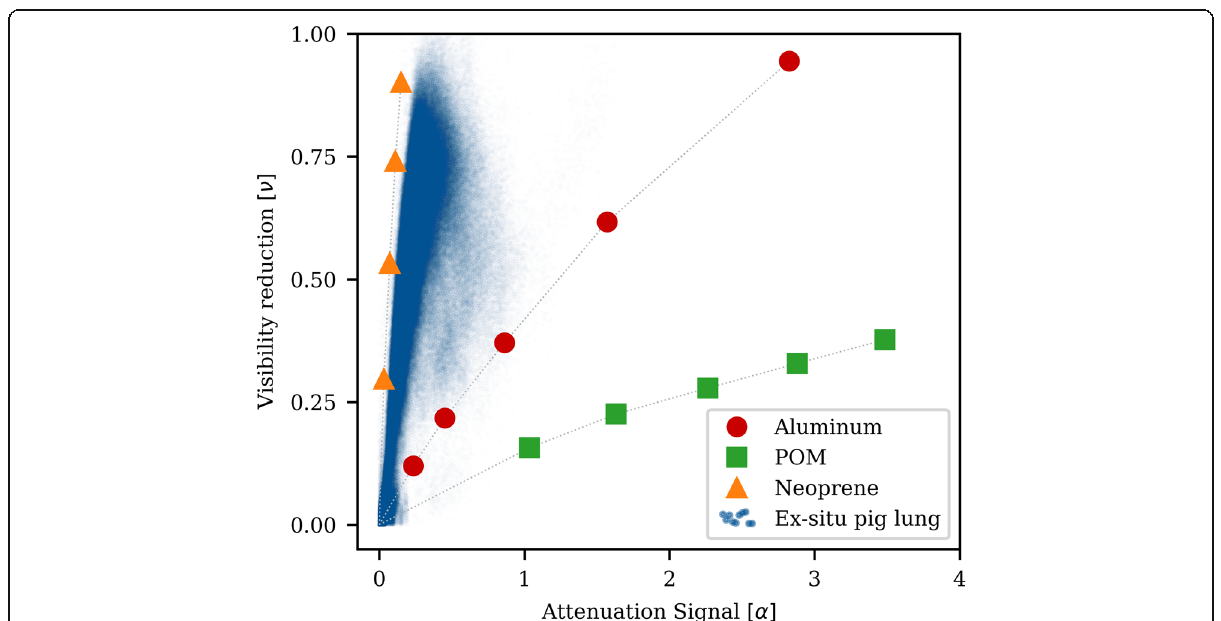
Fig. 4 Effect of beam hardening and small-angle scattering on the x-ray dark-field signal. Measured with 1, 2, 4, 8, and 16 mm of aluminium; 3, 5, 7, 9, and 11 cm of polyoxymethylene (POM); 1, 2, 3, and 4 cm of neoprene and an ex situ pig lung. Although no scattering object was in the beam path during the measurement of POM and aluminium, an apparent dark-field signal was generated by beam hardening. Aluminium exhibits similar spectral attenuation properties as the bone, whereas POM more closely approximates soft and adipose tissue. The large discrepancy between the two curves explains the strong apparent dark-field signal due to the bones in Figs. 1, 2, and 3, despite application of a POM-based beam hardening